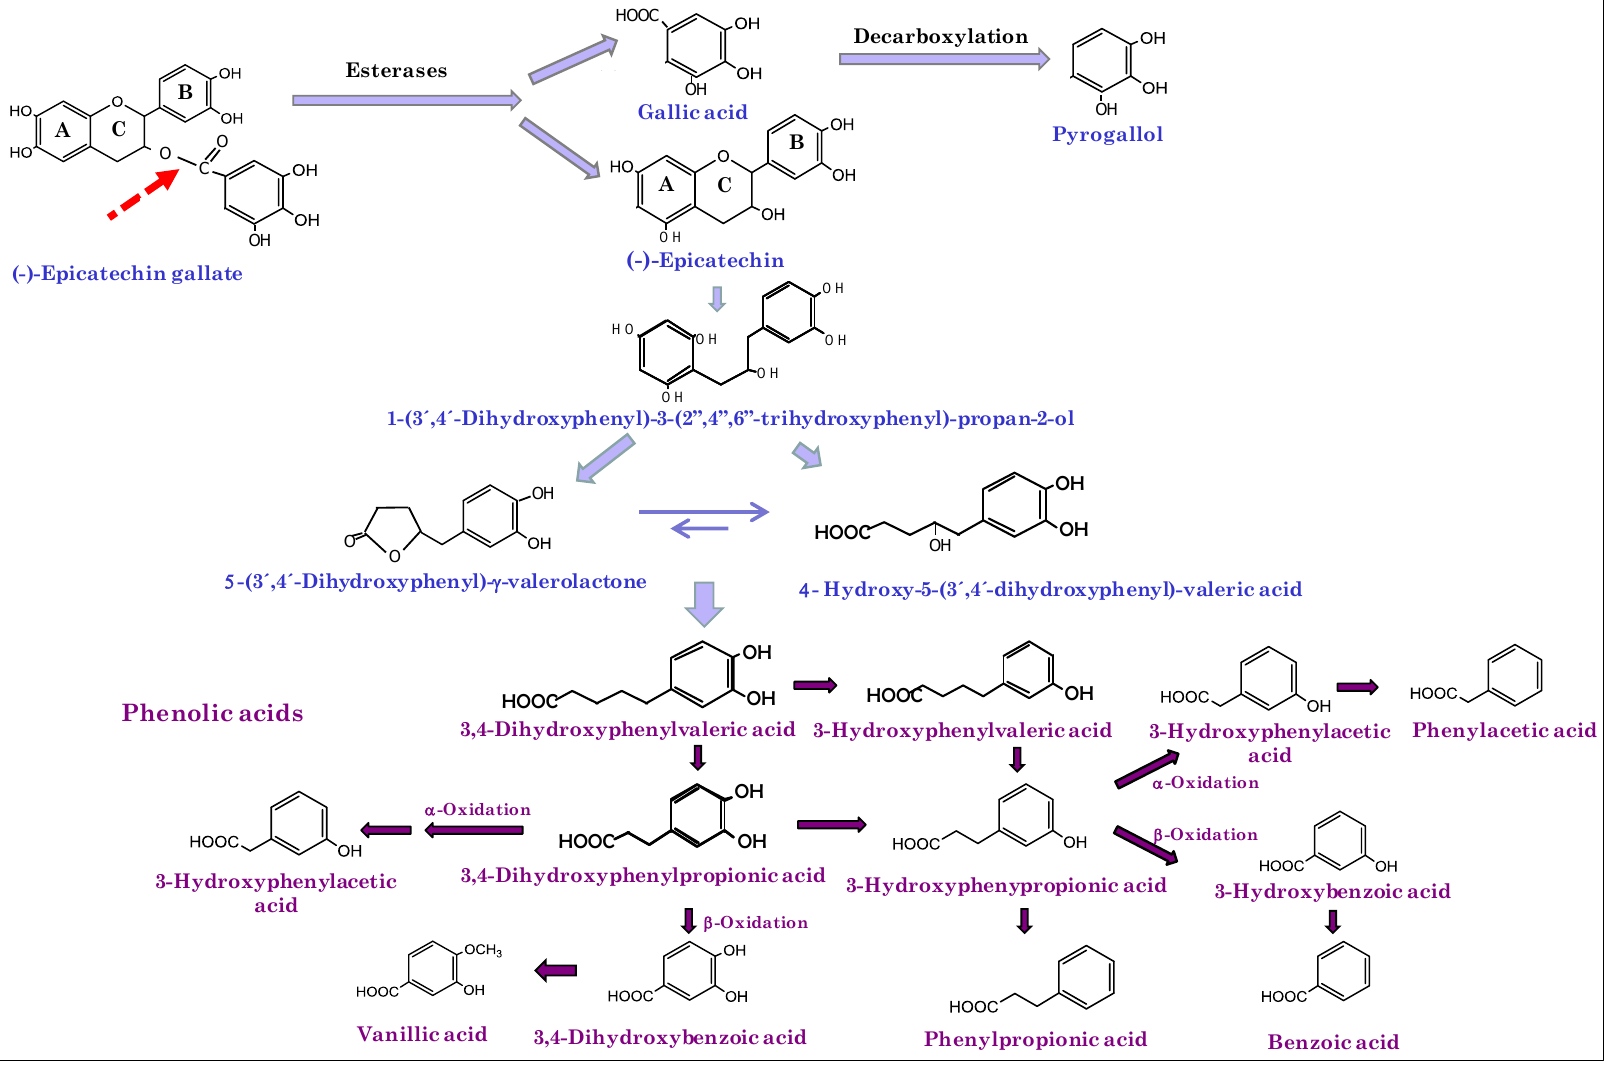
Figure 2. Metabolic pathway for the degradation of monomeric flavans-3-ol by gut